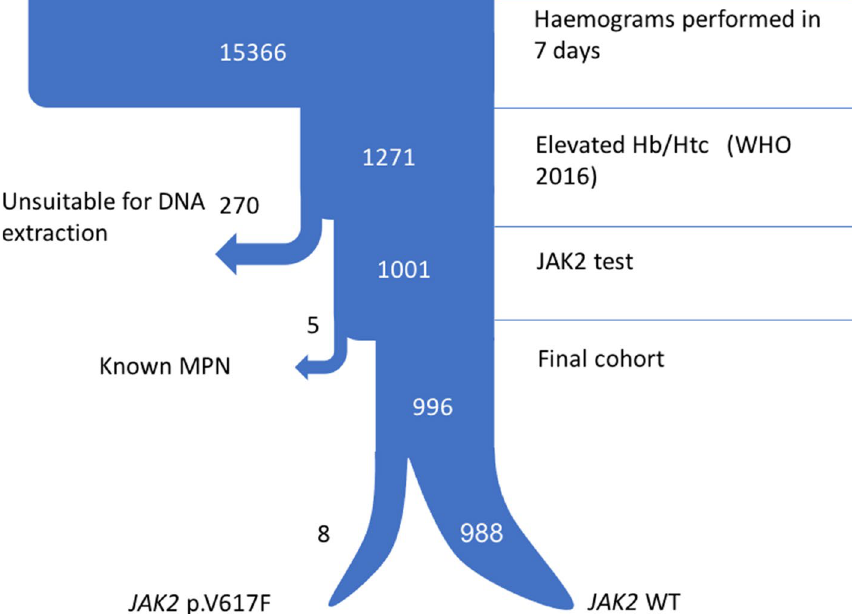
Figure 1. Step 1 sample flowchart. This figure contains a diagram of the sample selection process. WHO World Health Organization, MPN myeloproliferative neoplasm, WT wild type.